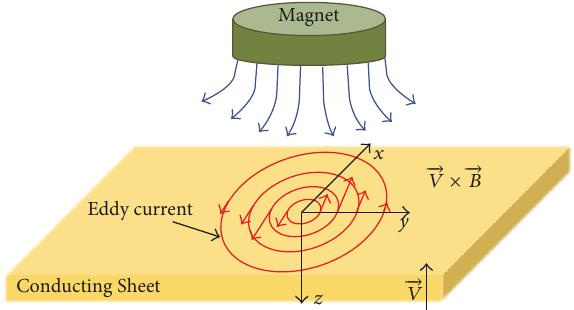
Figure 4: Schematic of eddy currents